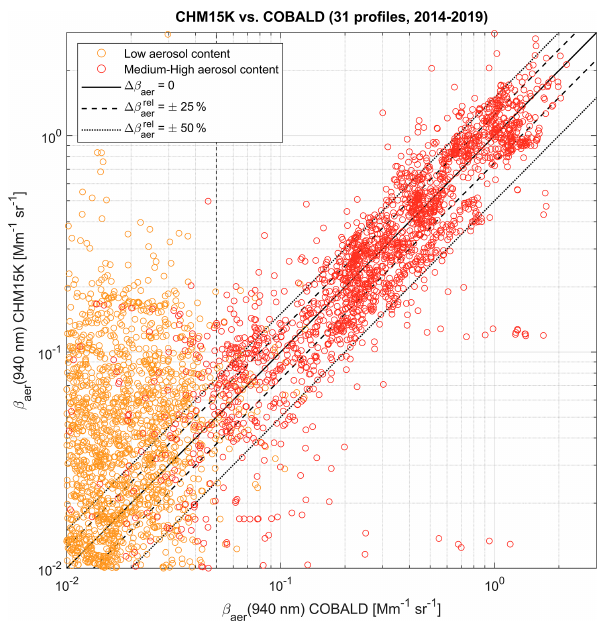
Figure 10. Statistical comparison of CHM15K vs. COBALD: scat- terplot. All medium-high-aerosol-content (red circles) and low- aerosol-content (orange circles) data points of aerosol backscat- ter coefficient ( β aer ) at 940nm measured by CHM15K ( y axis) vs. β aer at 940nm measured by COBALD ( x axis). Thin black lines show 1 : 1 agreement (solid), ± 25% difference (dashed) and ± 50% difference (dotted) isolines. The 0.05Mm − 1 sr − 1 thresh- old in COBALD β aer , separating low- from medium-high-aerosol- content data at 940nm (as described in Sect. 3.3), is shown by a dashed vertical black